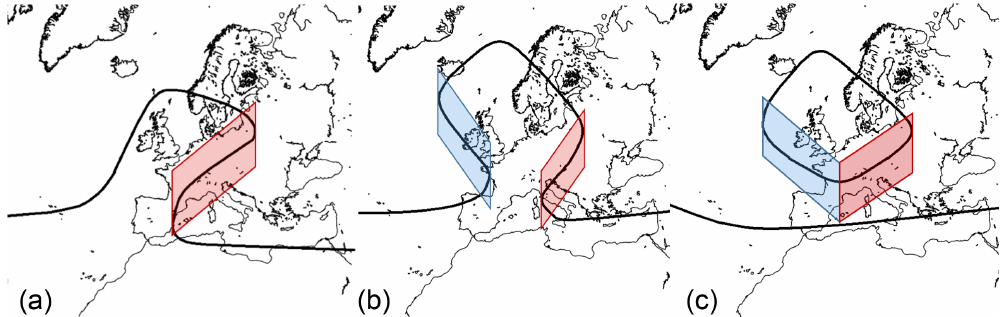
Figure 6. (a) Schematic of a mature warm-anticyclonic Rossby wave breaking event on the dynamical tropopause, with a region of positive BI and anticyclonic DB index values shaded red. The black contour portrays an arbitrary potential temperature contour representing the intermediate between anomalously cold and warm air masses. (b) Schematic of an (cid:127) block with an additional cold-cyclonic Rossby wave breaking event (blue) following (a) . (c) Schematic of a final stage warm θ cut-off.